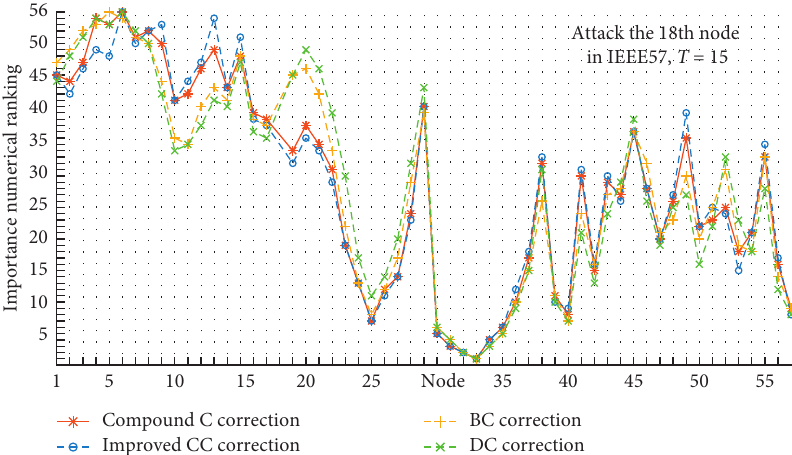
Figure 9: Importance numerical ranking under compound C, improved CC, BC, and DC correction at T � 15. Table 3: Compound centrality and S value of node under the IEEE57 attacking the 18th